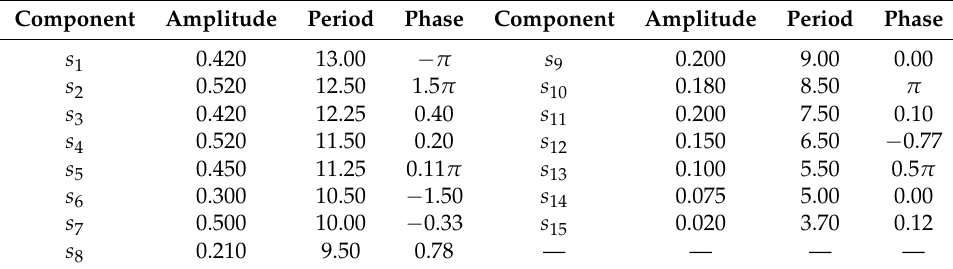
Table 6. Sinusoidal components used for sea-state (values expressed in international units).